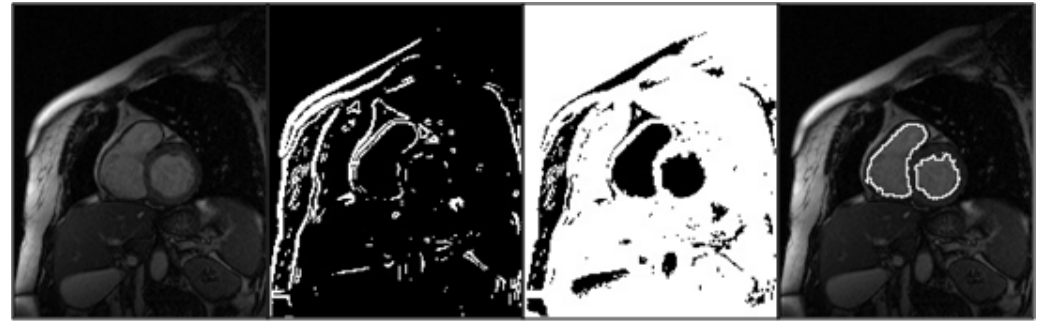
Figure 2. Semiautomatic segmentation scheme showing, from left to right: original gray-scale image, edge detection after iterative thresholding (binary image 1), background overlapping of binary images 1 and 2 (binary image 3), and region growing